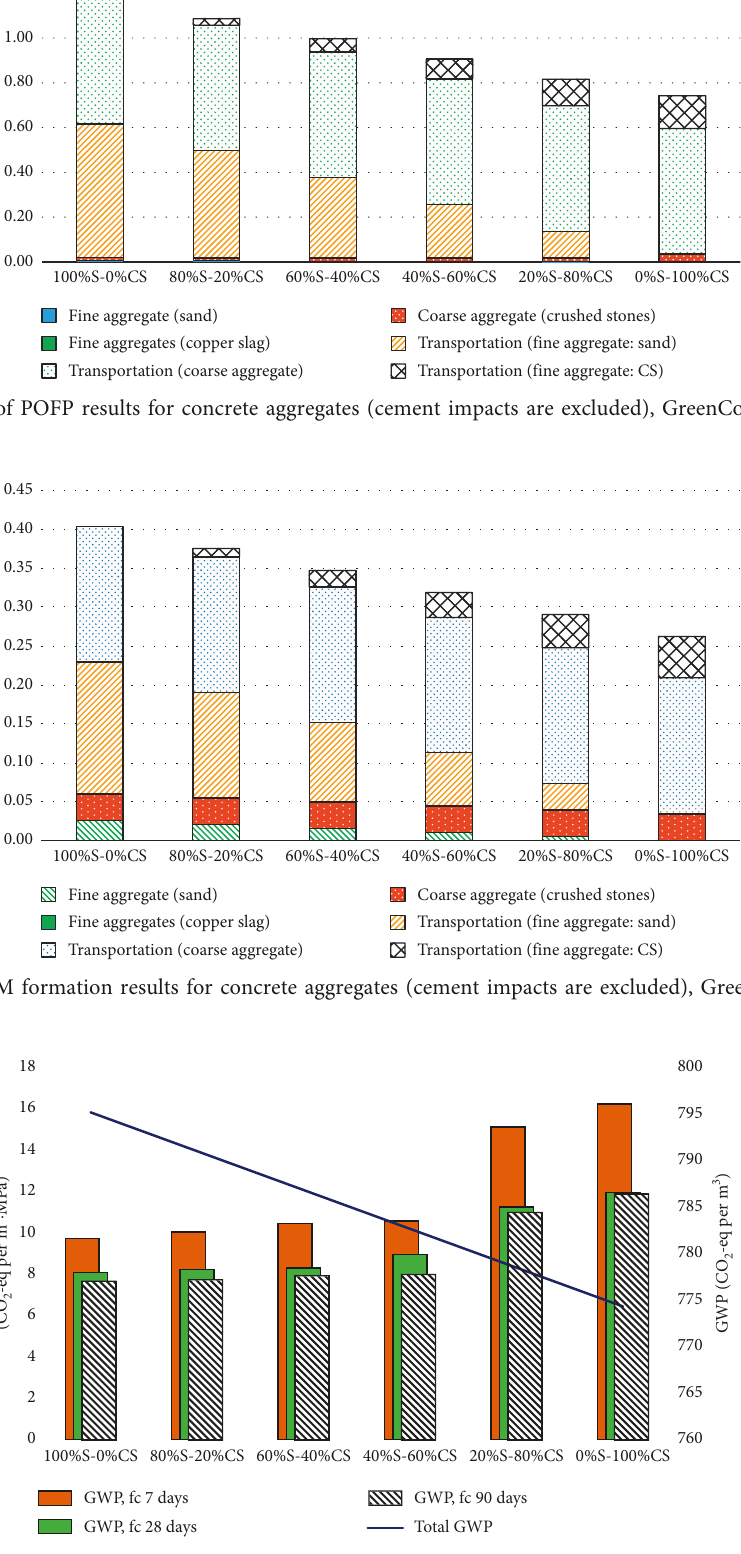
Figure 9: Normalized GWPs of concrete mixes with respect to their compressive strengths at varying curing ages, GreenConcrete LCA tool